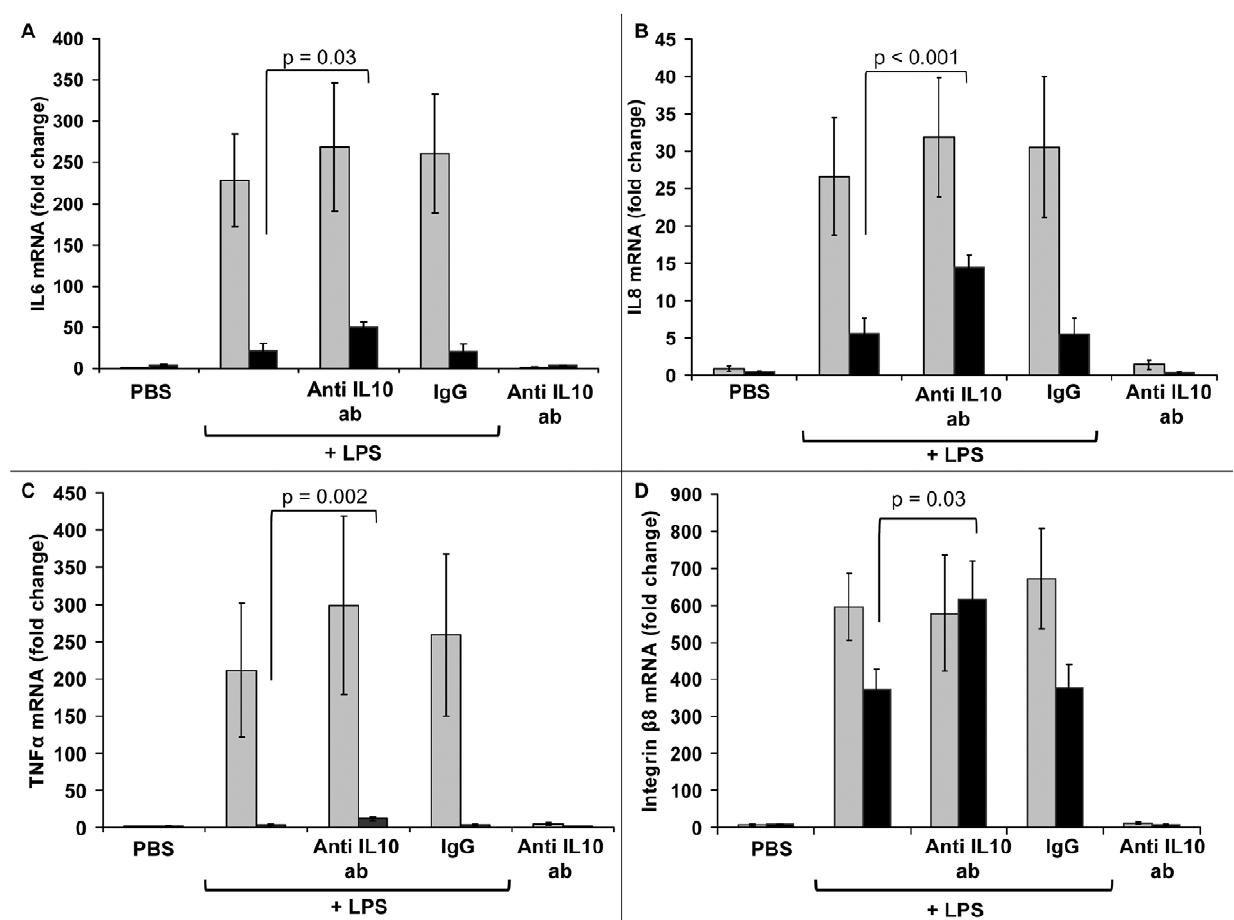
Figure 1. Analysis of IL-6, IL-8, TNF a and integrin b 8 mRNA by RT-qPCR in monocytes. Monocytes from the newly born were preincubated with anti-IL-10 antibody for 1 hr followed by endotoxin (LPS) stimulation for 4 h (gray bars) and 18 h (black bars). PBS alone, anti-IL-10 antibody (ab) without LPS stimulation and IgG with LPS served as controls. Values are mean 6 SE (n=6).